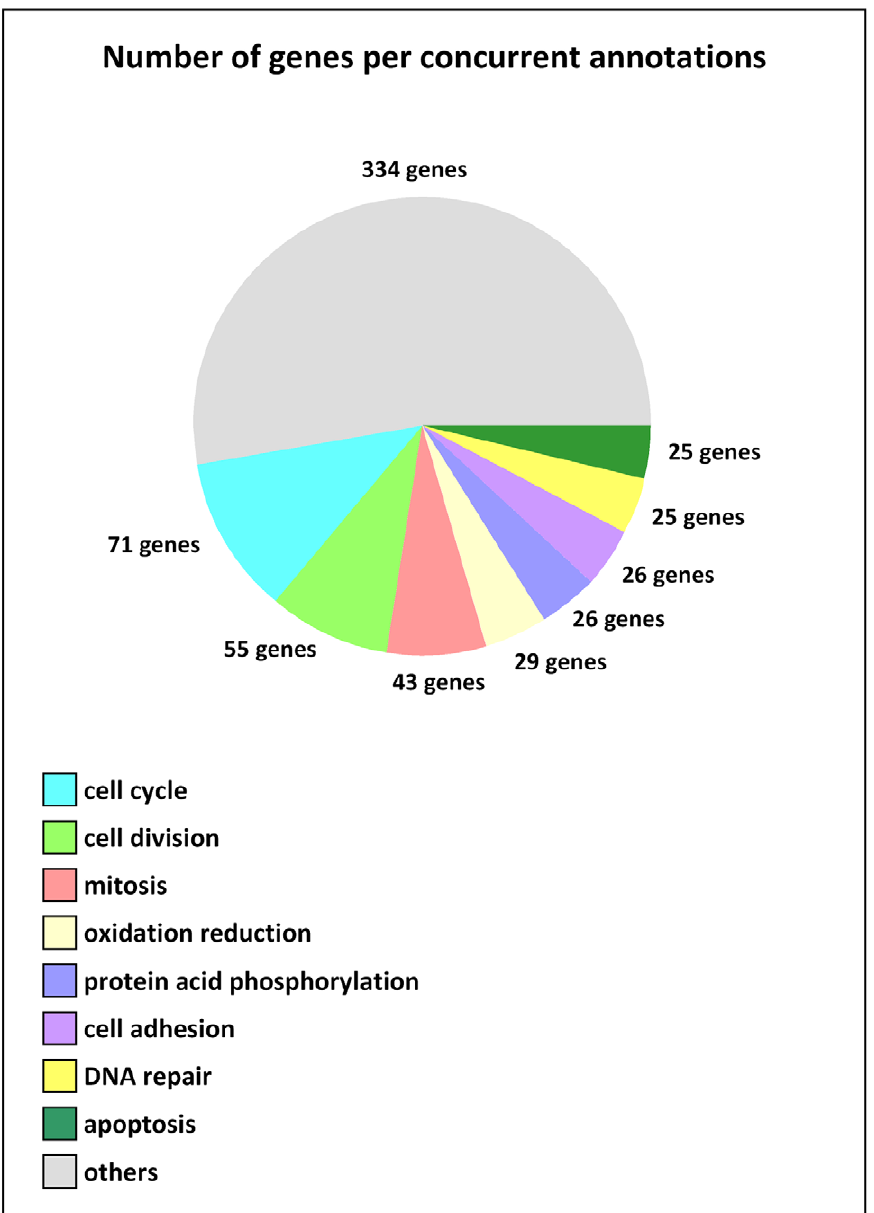
Figure 1. Gene singular annotation of DNA microarrays data. U2OS cells were independently transfected using two controls and two different p400-targetting siRNAs. Total RNA was then prepared 48 h later and submitted to reverse transcription, cDNA control quality and hybridization on Affymetrix DNA microarrays (GeneChip Human Gene 1.0 ST Array). Following quantification of two independent experiments, normalization and statistical analysis was done using GeneSpring GX software (Agilent Technologies). Qualified genes were those found regulated, in the same way, in at least 3 out of the four comparisons (p400-targeting siRNAs versus controls) and with a fold change at least equal at 1.25. Presented gene annotation discovery was done using GeneCoDis2 online software.